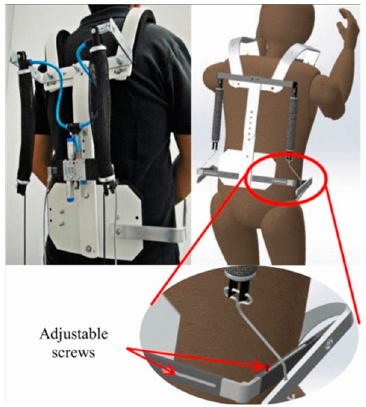
Figure 3. Backbone pneumatic exoskeleton [63]. Reprinted with permission from IEEE. License